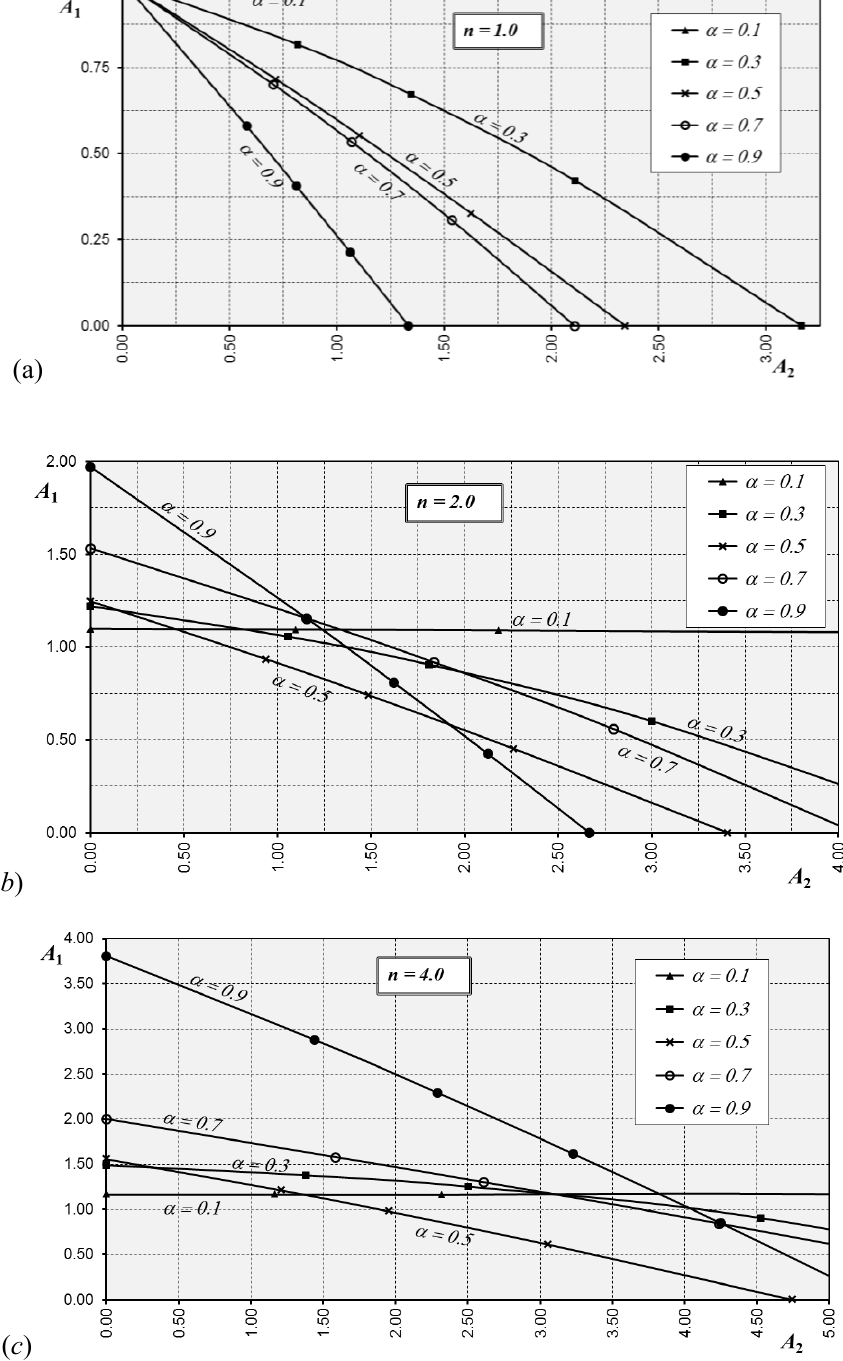
Fig. 4. Bucking loads parameters of columns with clamped – pinned ends (C-P). under intermediate load P and end load P 2 1 n=1.0, (b) n=2.0 and (c)